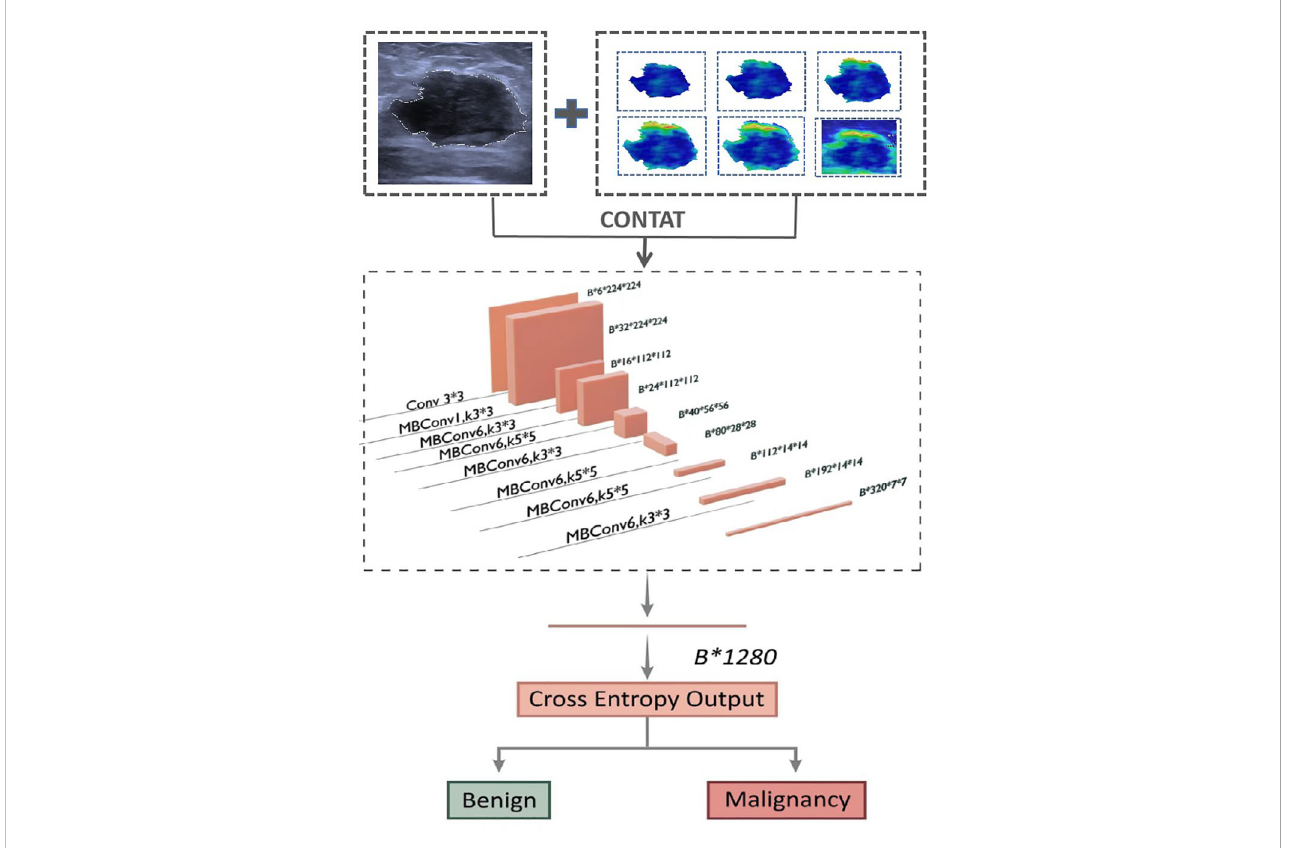
FIGURE 5 Network architecture of dual-modal prediction model for breast cancer. The input layer